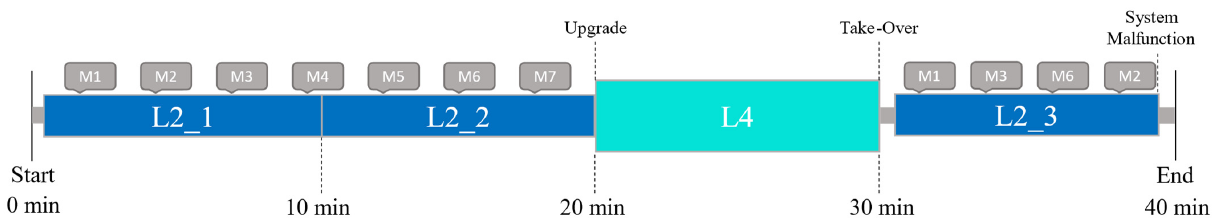
Figure 3. Different segments of the experimental drive, including the order of affective messages and levels of automation. Manual driving durations (grey) can be disregarded.